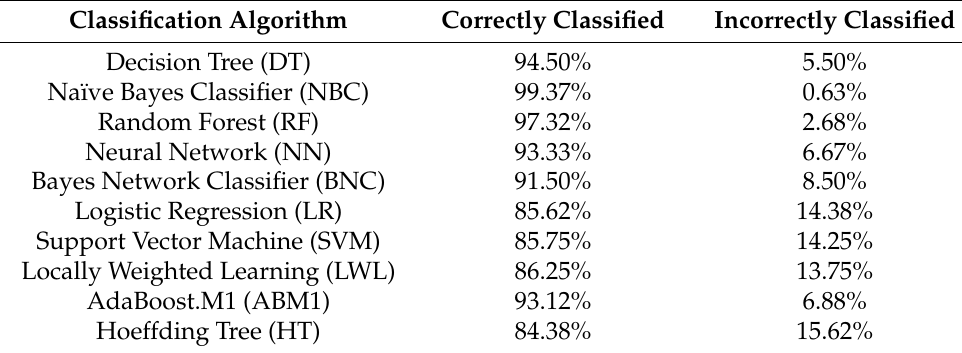
Table 1. Crowd data accuracy for machine learning classification